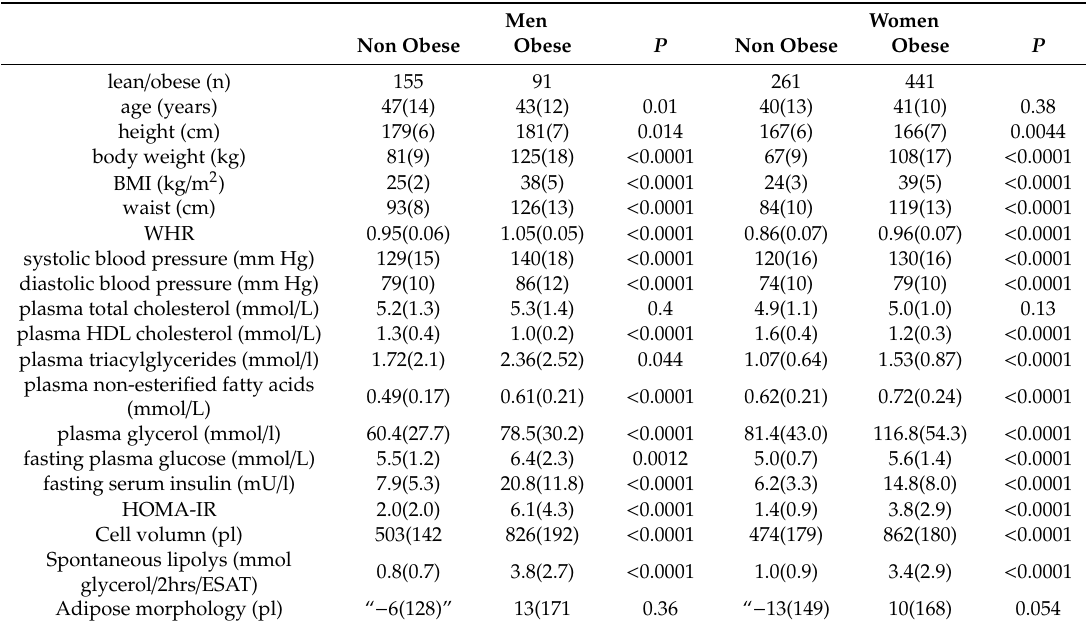
Table 1. Characteristics of participants in the GENetics of Adipocyte Lipolysis (GENiAL) cohort used for the analysis of adipose